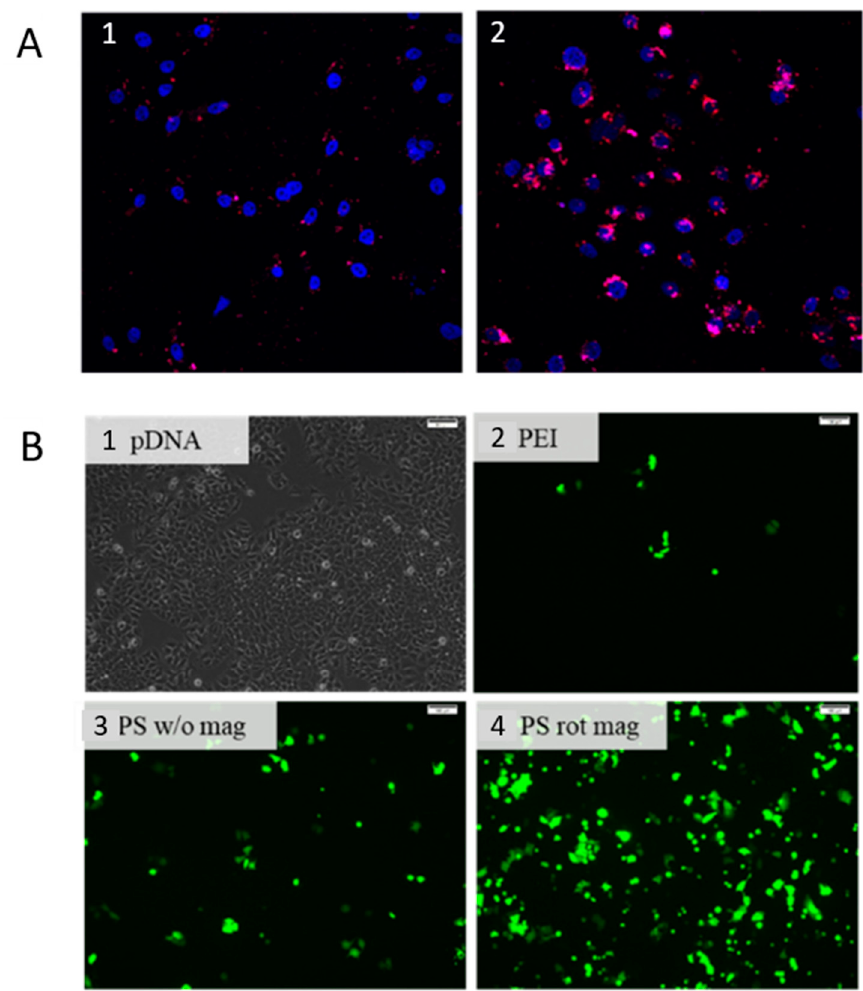
Figure 7. Intracellular imaging experiment tracking fluorescent particles delivered by NPs. ( A ) Polyethyl-enimine modified GO with Luciferase reporter vector (PEI-GO/pGL-3) complexes labeled with Cy3 (red) in HeLa cells at ( 1 ) 4 h and ( 2 ) 24 h post-transfection. 4 ′